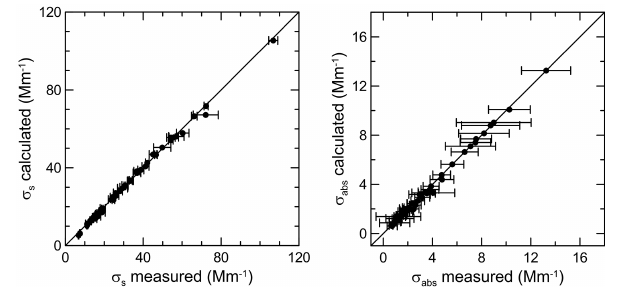
Figure 7. Comparison of the aerosol scattering ( σ s , left panel) and absorption ( σ abs , right panel) coefficients measured by the neph- elometer and the aethalometer and calculated from measured size distribution data with Mie theory for an optimized refractive index. Data are given at ambient conditions. Uncertainties on the mea- sured (horizontal bars) scattering and absorption coefficients are also shown in the